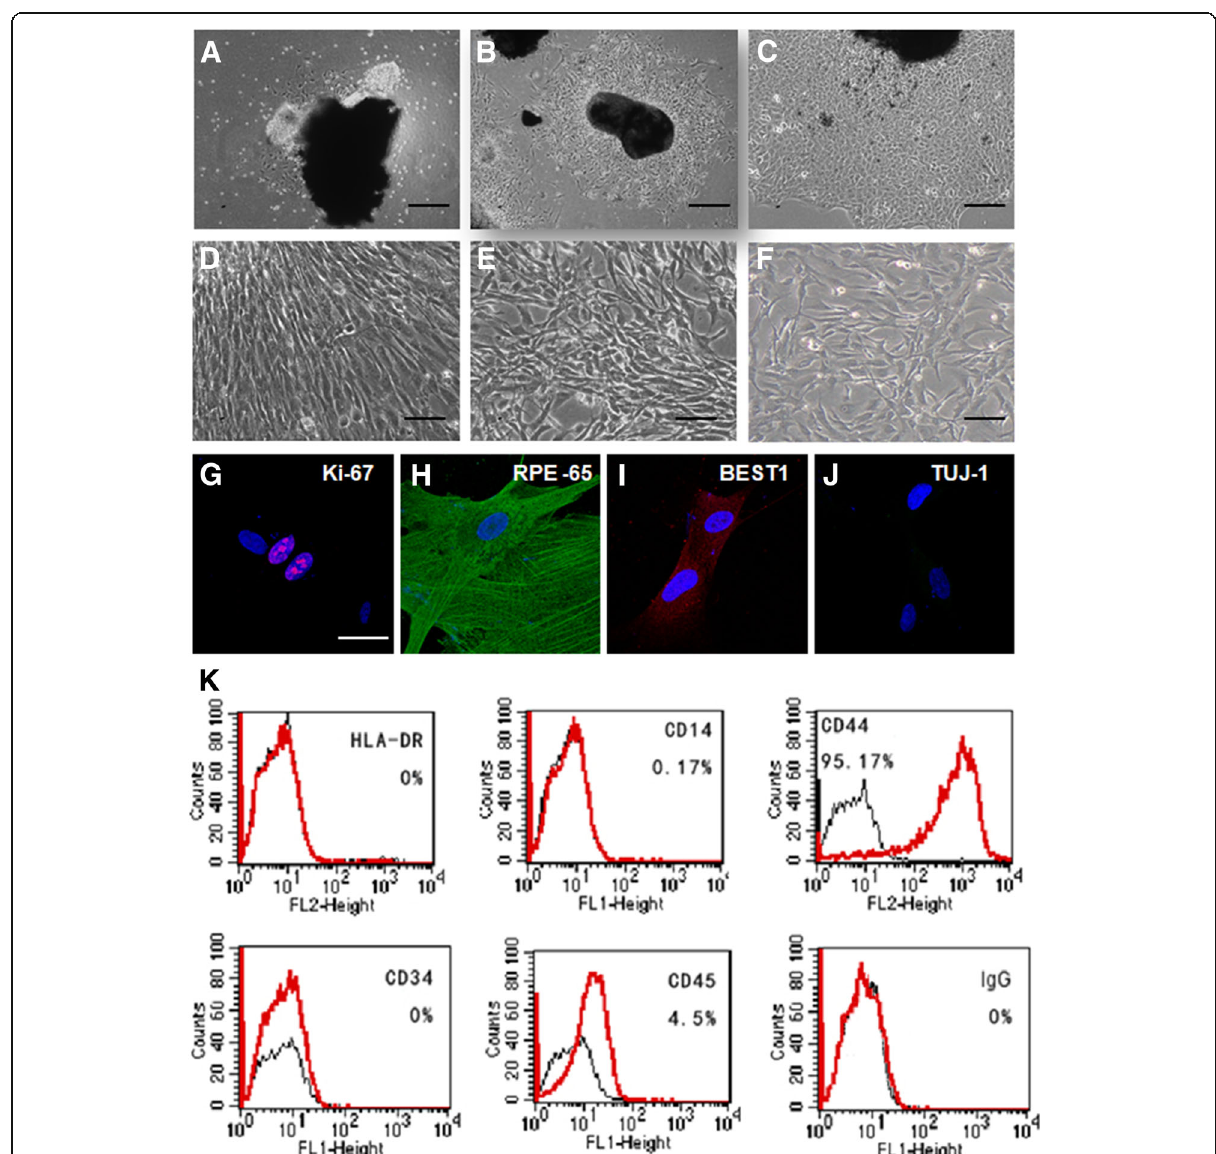
Fig. 1 Isolation and characterization of cells from adult human RPE tissues. ( a - c ) Phase-contrast microscopy (A) of cultured RPE monolayer tissues. A small number of cells migrated out from the edge of the tissues. b , c While the cell layer expanded, the center tissues shrunk. The cell layer exhibited classical epithelial morphology with flat cell bodies possessing processes extending out from the cell body (scale bar: 100 μ m). d - f Representative microscopy images of RPE cells at passages P1 ( d ), P10 ( e ), and P20 ( f ) (scale bar: 50 μ m). g - j Characterization of cultured RPE cells by immunofluorescent staining using an antibody against Ki67 for proliferation ( g ), RPE65 ( h ) and BEST1 ( i ) for retinal pigmented epithelium, and Tuj1( j ) for pan-neural cells (scale bar: 20 μ m). k Flow cytometry analysis of the expression of HLA-DR, CD14 for endothelial, CD34 and CD45 for hematopoietic, and CD44 for proliferative progenitor